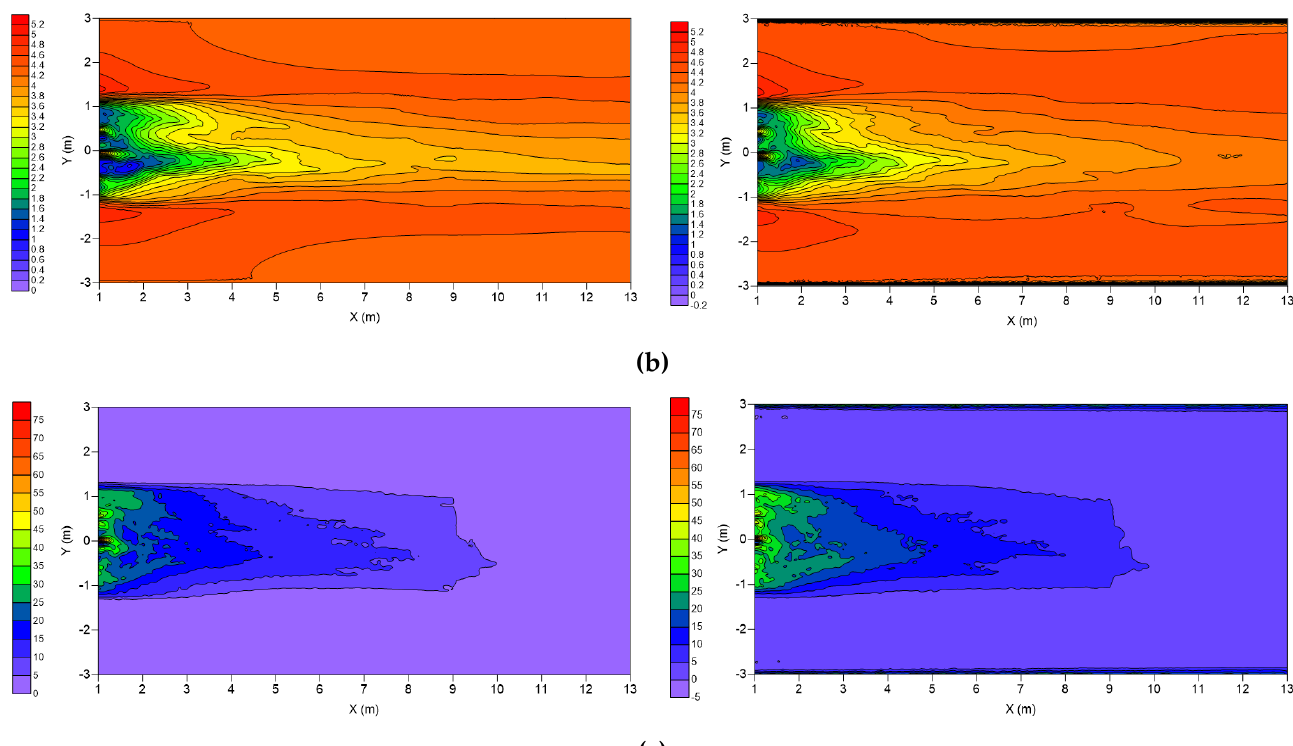
Figure A1. Time-averaged spatial distribution of ( a ) pressure ( b ) velocity and ( c ) vorticity fields for the healthy and damaged VAWTs.